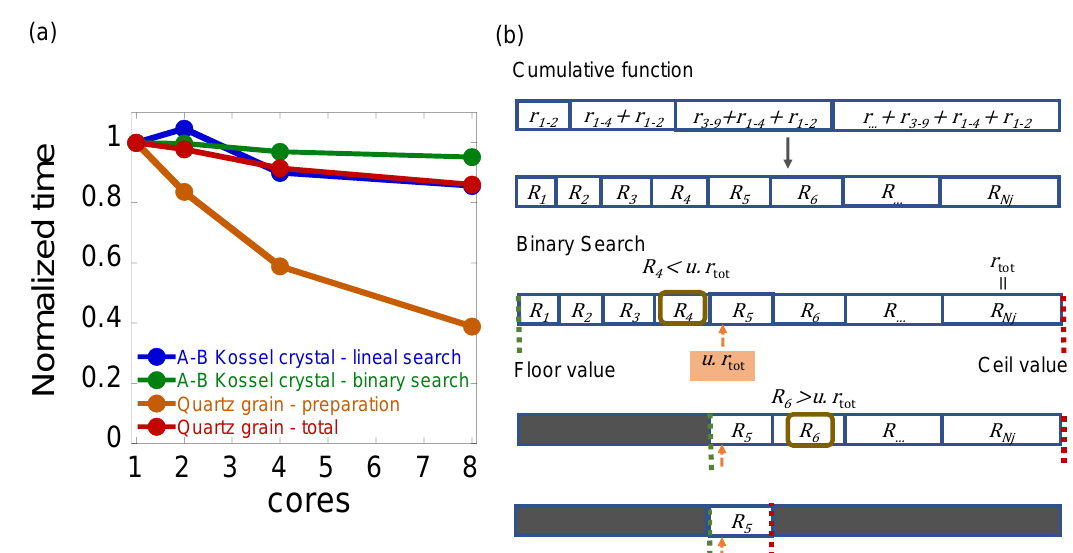
Figure 3. ( a ) Normalized simulation time of the examples with the number of cores. The A-B Kossel crystal example in blue and green (‘configuration 1’ explained below) presents with both search algorithms a simulation time with 1 core of 18885 s in our computer. The total simulation time for the quartz grain in red 2255 s with 1 core, and its preparation phase in orange 902 s. ( b ) Binary search working scheme. The target value is successively limited if it is not